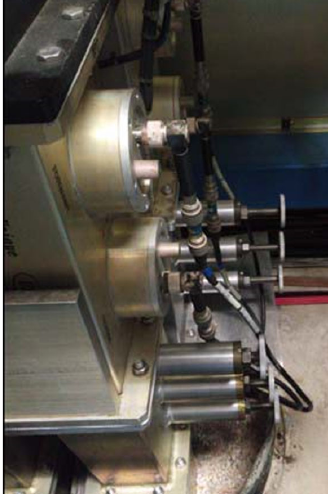
FIG. 10. Picture of WR650 three-plunger stub tuners accessible in the CEBAF service buildings within klystron